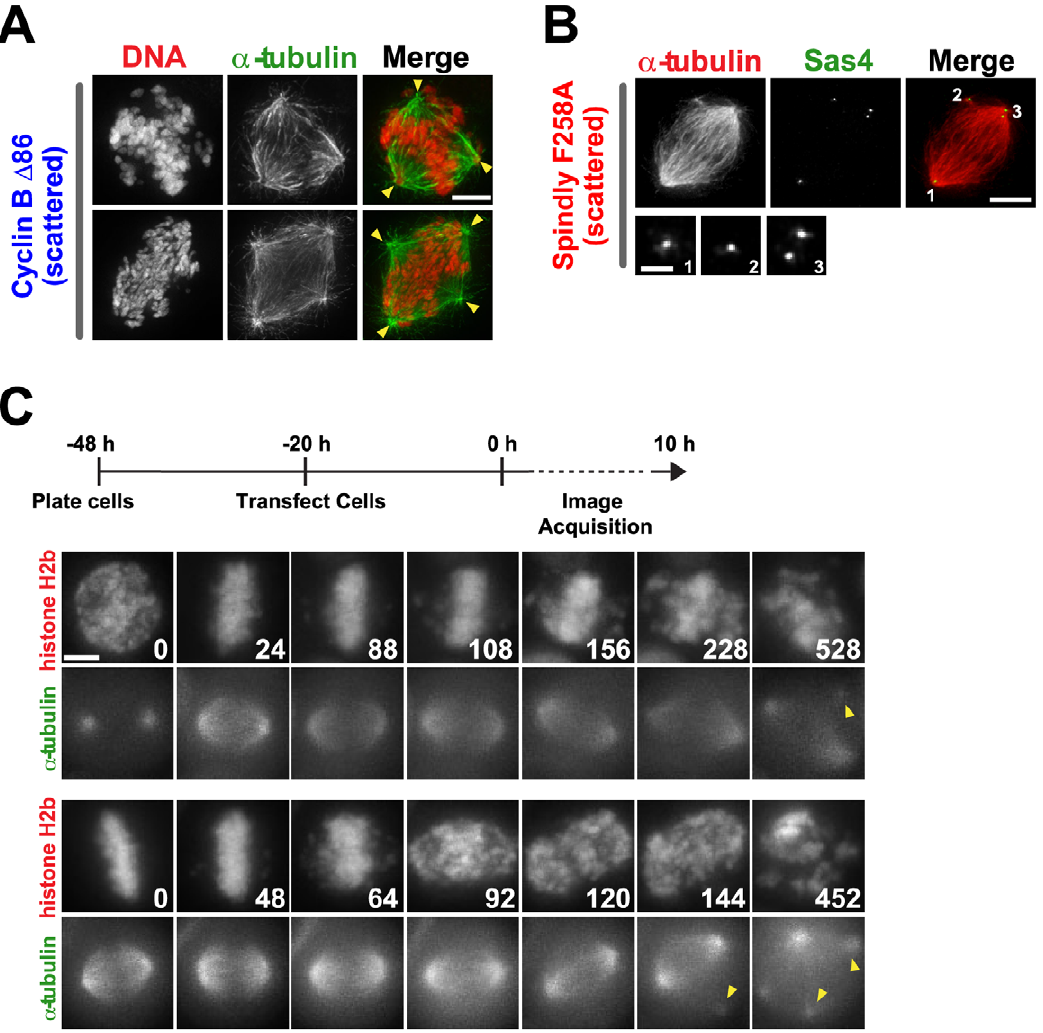
Figure 2. Chromosome scattering results in spindle defects that are secondary to loss of cohesion. ( A, B ) Immunofluorescence images of scattered cells stained with DNA and (A) a -tubulin [arrowheads denote all spindle poles] and (B) centriole marker Sas4. Scale bar, 5 m m; magnified image 1 m m. ( C ) Selected images from time-lapse imaging sequences of cells expressing mRFP:histone H2b and YFP: a -tubulin. The experimental scheme is depicted above the images. Time (in mins) is indicated on the lower right of each panel; time 0 for panel set 1 is NEBD and for panel set 2 full alignment in metaphase. Arrowheads indicated the appearance of extra spindle poles. Scale bar, 5 m m.